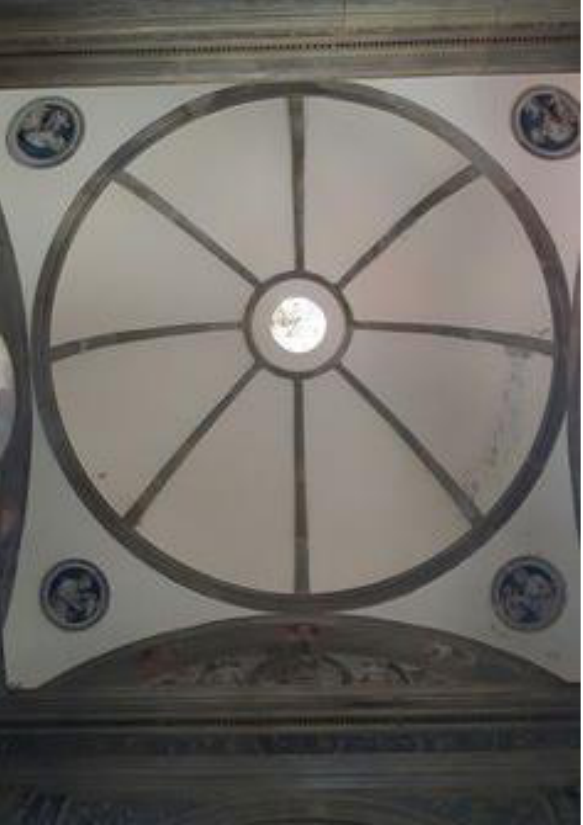
Figure 3. Naples, Sant’Anna dei Lombardi Church. Tolosa Chapel (about